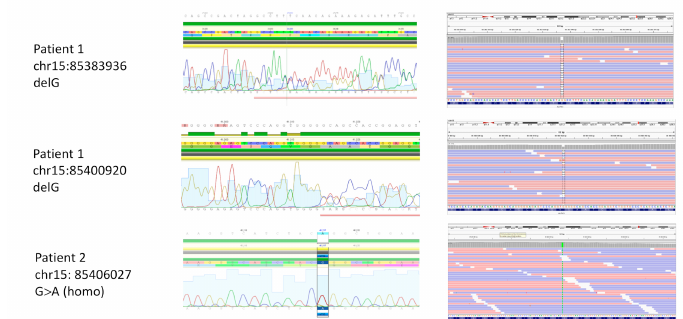
Figure 3. ALPK3 variants, leading to cardiomyopathy in combination with skeletal muscle features. Sequencing data obtained using whole exome (Patient 1) and target (Patient 2) sequencing confirmed by Sanger sequencing. Compound heterozygous variants c.2033delG: p.R687fs and c.3558delG: p.V1186fs in Patients 1, and homozygous variant c.G4897A: p.G1633R in Patient